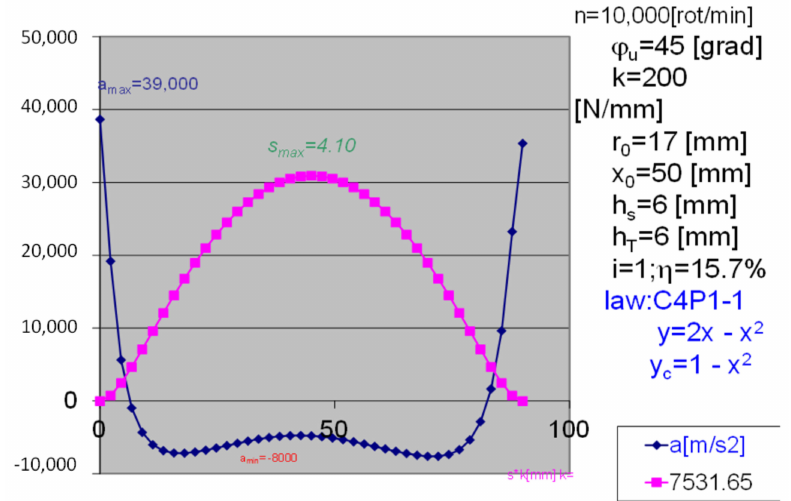
Figure 11. Dynamic analysis of the law C4P, ϕ u = 45 [degree], n = 10,000 [rpm], for the classic module with rotating cam and translation tracker with sole.